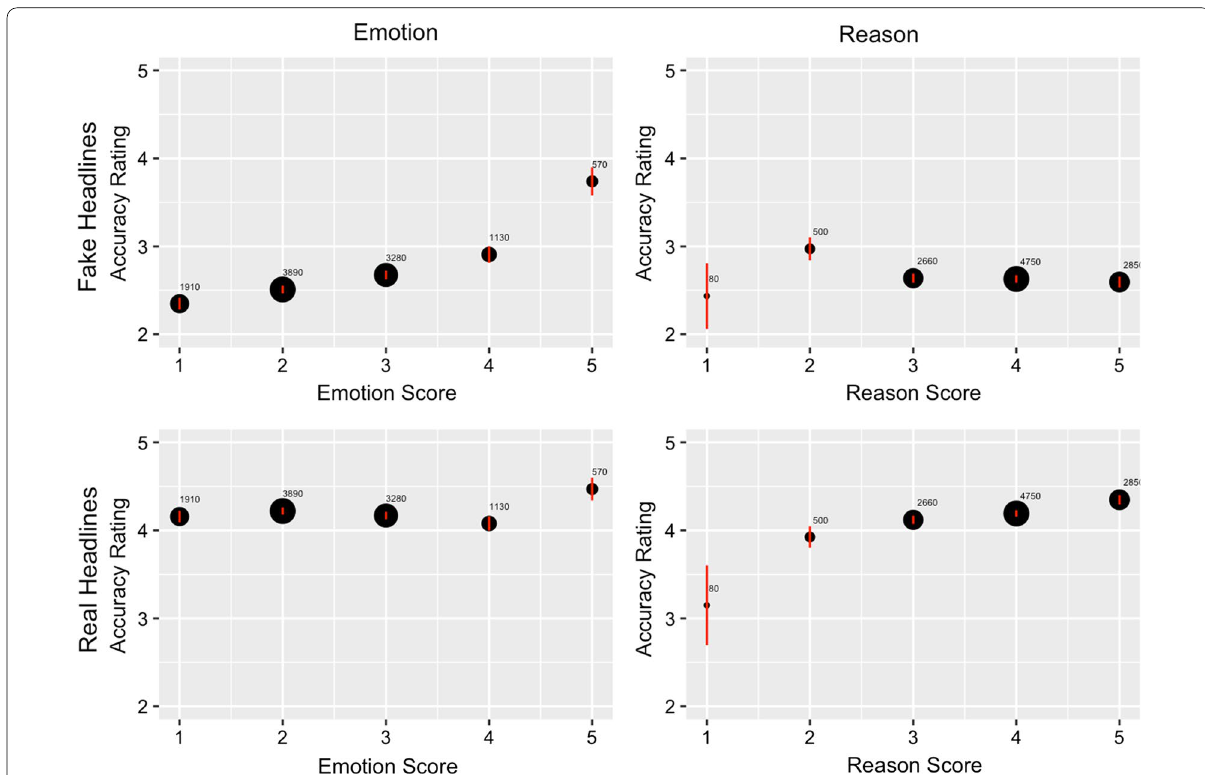
Fig. 3 Plotting reported news headline accuracy as a function of use of emotion or use of reason shows a positive relationship between emotion and belief in fake news, and a positive association between reason and belief in real news. Dot size is proportional to the number of observations (i.e., a specific participant viewing a specific headline). Error bars, mean 95% confidence ±